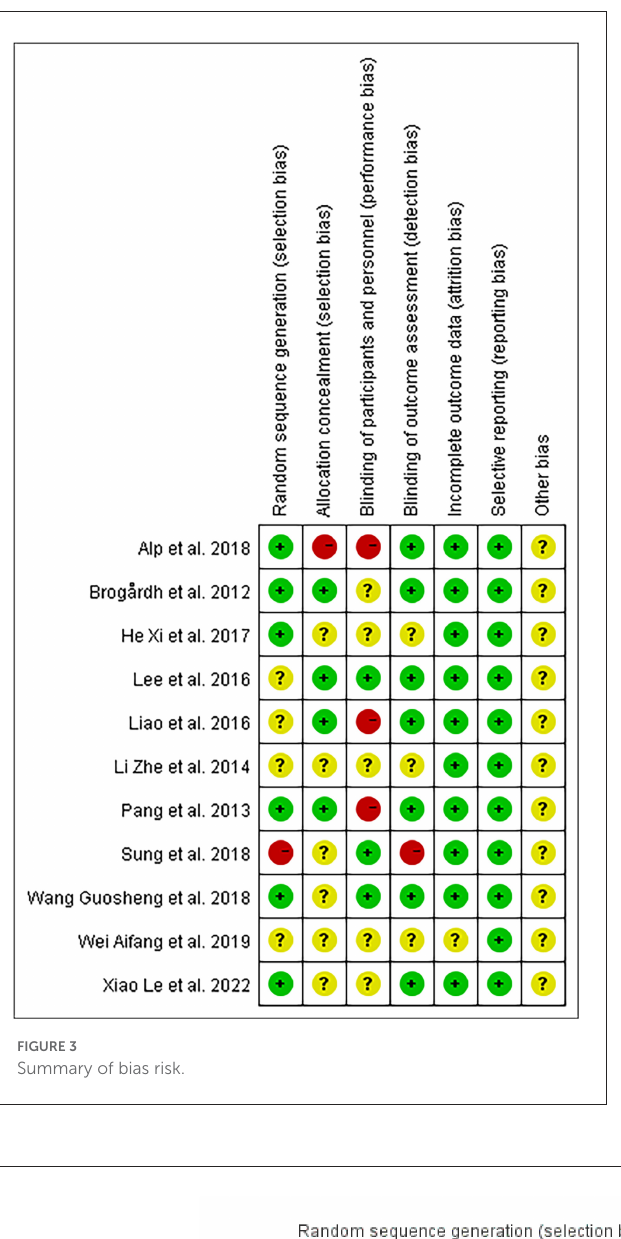
(Figure 8); for patients with a lower limb (SMD = − 0.21, 95% CI: − 0.40 to − 0.01, P = 0.04), WBV was added to other therapies, and it also outperformed the control treatments (Figure 8).